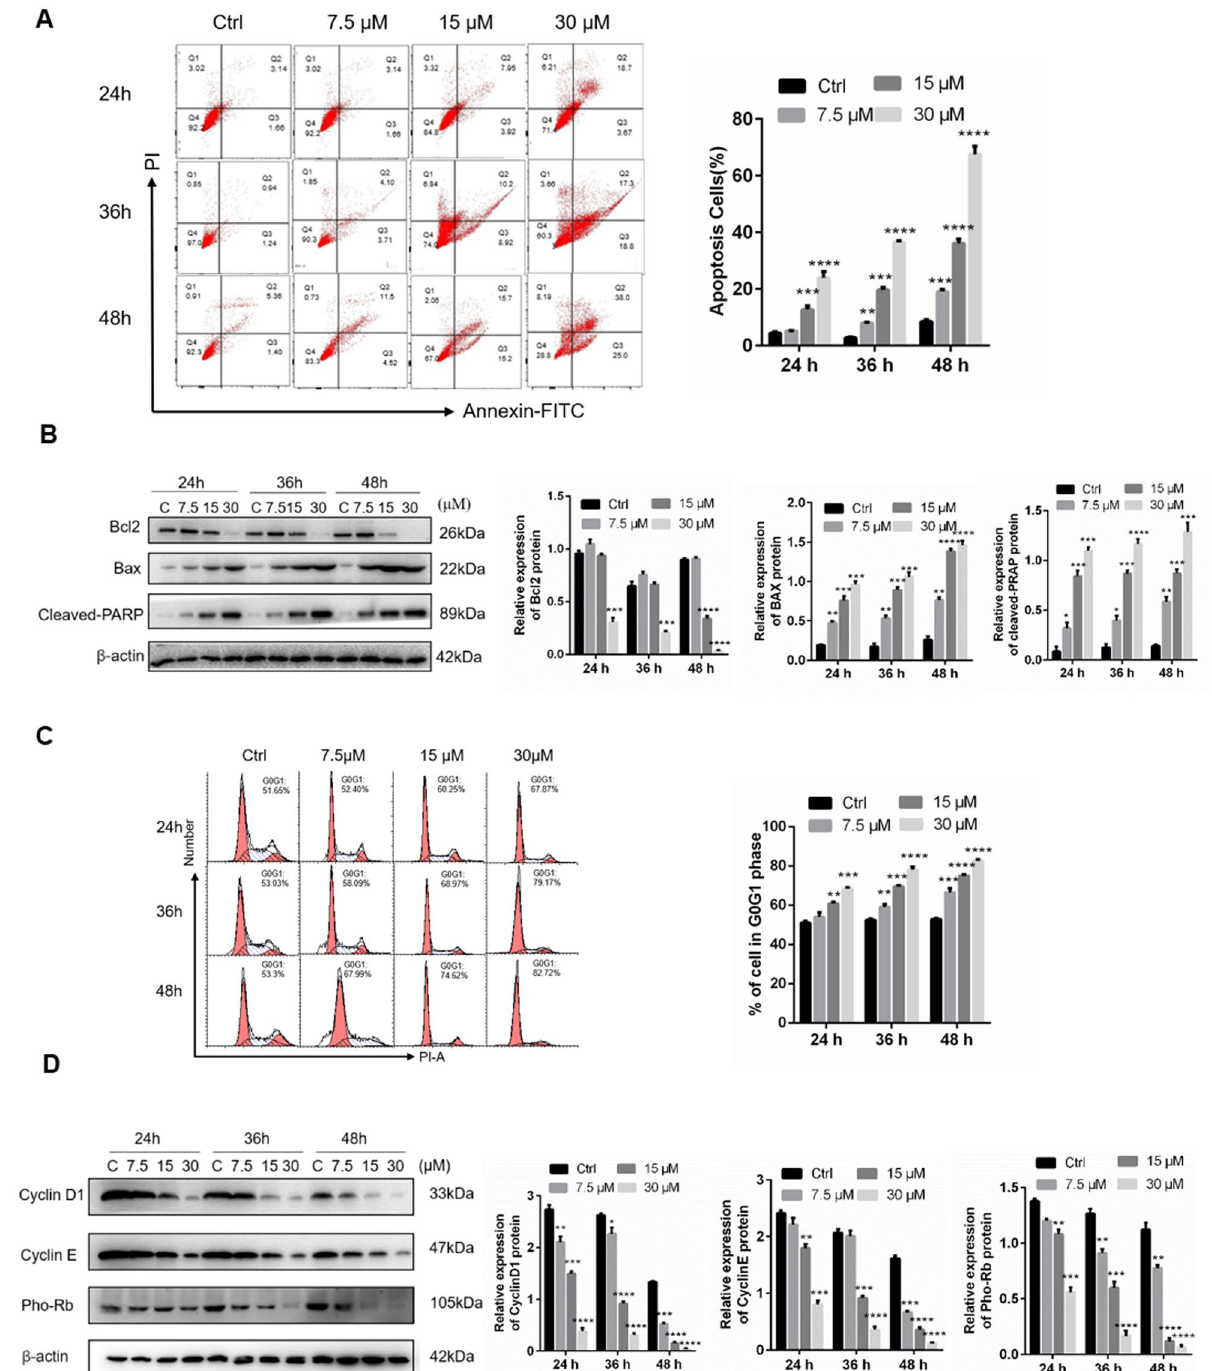
Figure 2. Rafoxanide promotes A549 cell apoptosis and induces cell cycle arrest. ( A ) A549 cells were treated with rafoxanide (0, 7.5, 15 and 30 μM) for 24, 36 and 48 h, and apoptosis was analyzed using flow cytometry. ( B ) Western blotting was performed to evaluate the protein expression levels of apoptosis-related proteins, including cleaved PARP, Bax, the anti-apoptotic protein Bcl-2, and phosphorylated Rb. The relative expression levels of cleaved PARP, Bax, Bcl-2, and phosphorylated Rb were analyzed with ImageJ based on the band intensities. ( C ) Flow cytometry was used to assess the effect of rafoxanide (0, 7.5, 15, and 30 μM) for 24, 36, and 48 h on the cell cycle. Columns show the percentage of the cell population in the G0/G1 phase. ( D ) Western blot analysis of the cell cycle-related proteins cyclin D1, cyclin E and phosphorylated Rb. The relative expression levels of cyclin D1, cyclin E and phosphorylated Rb were analyzed with ImageJ based on the band intensities. Data are expressed as the mean ± SD of three experiments. * P < 0.05, ** P < 0.01, *** P < 0.001, **** P <